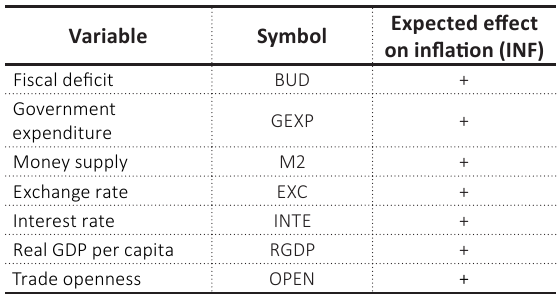
Table 1. Description of the